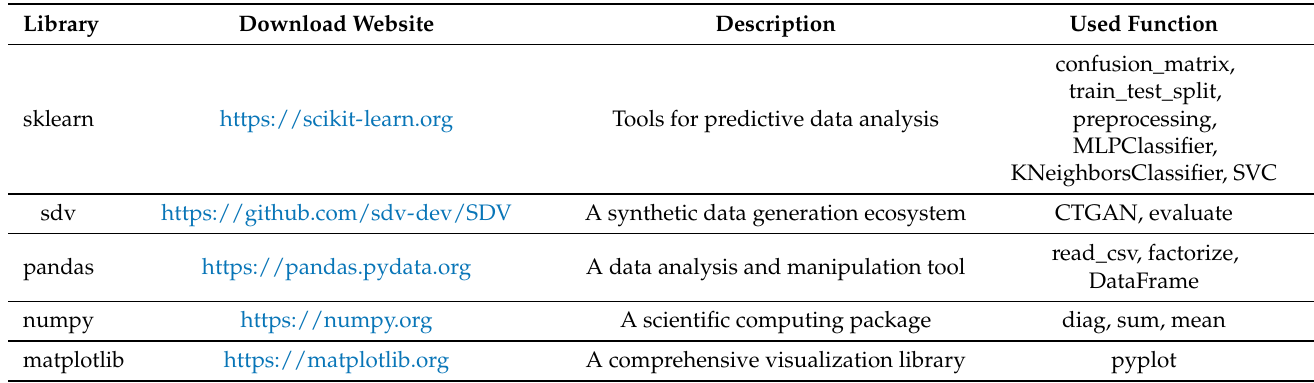
Table 3. The download website, description and used functions of the libraries (all web links accessed on 5 June 2022).